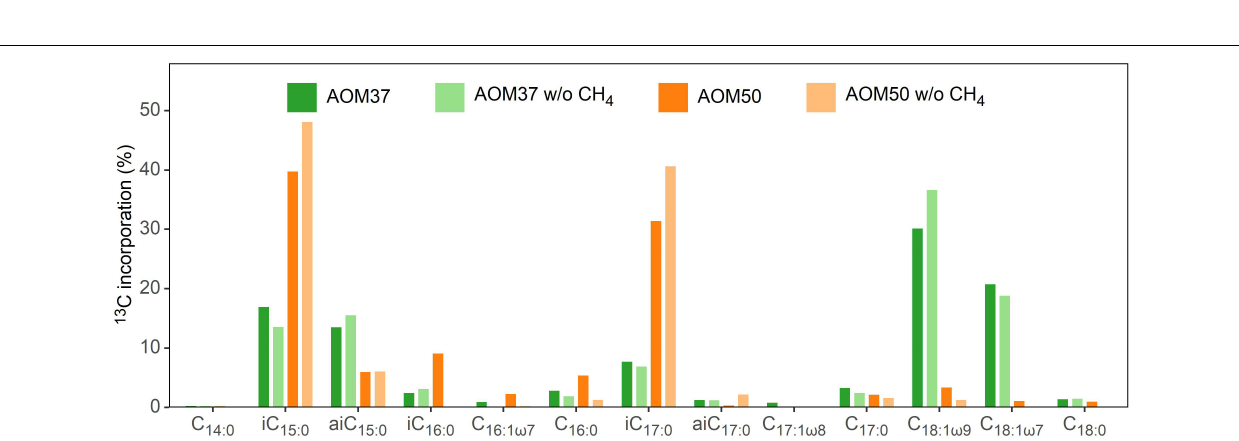
relative to T 0 ) of bacterial FAs during 13 C-leu incubation of AOM37 and AOM50 with and without (w/o) CH 4 over 28 FIGURE 3 | Development of δ 13 C values (in days (experiments 1 and 3, respectively). (cid:104)